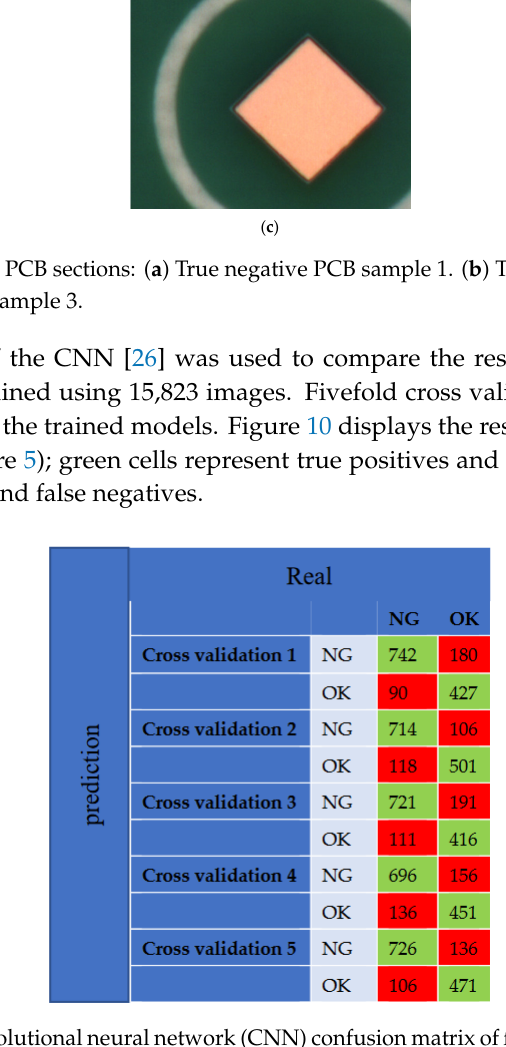
Figure 10. Vanilla convolutional neural network (CNN) confusion matrix of five cross validations. Note . True positive (TP): Cases in which damage is detected (NG) in the PCB and the PCB is defective (NG). True negative (TN): the PCB is predicted as OK and does not have any damage (OK). False